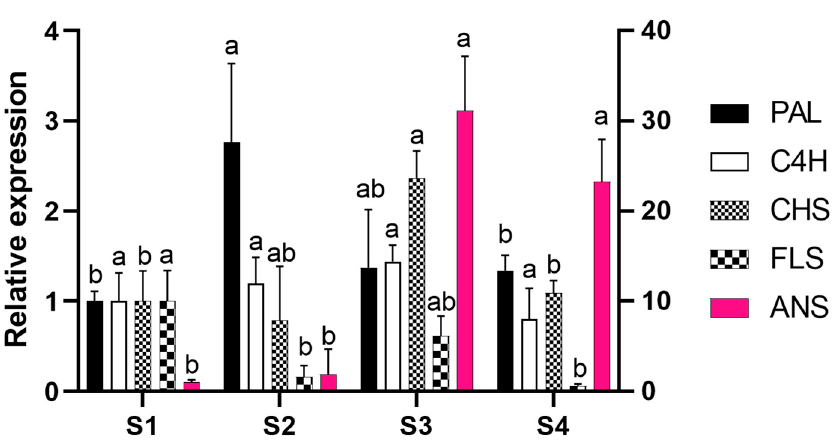
Figure 4. Expression profile of PHENYLALANINE AMMONIUM LYASE ( PAL ), CINAMMATE 4-HYDROXYLASE ( C4H ), CHALCONE SYNTHASE ( CHS ), FLAVONOL SYNTHASE ( FLS ), and ANTHOCYANIDIN SYNTHASE ( ANS ) genes during flower development. Data were normalised to expression of ELONGATION FACTOR 1 α ( EF1 ) and RIBOSOMAL PROTEIN S13 ( RPS ) and are expressed related to S1 stage. The right scale characterises ANS expression. Bars indicate standard deviation. For each gene, different letters indicate statistically different relative expression ratios. S1 — buds (day 0), S2 — white flowers (day 1), S3 — pink (day 2), S4 — purple (day 3).